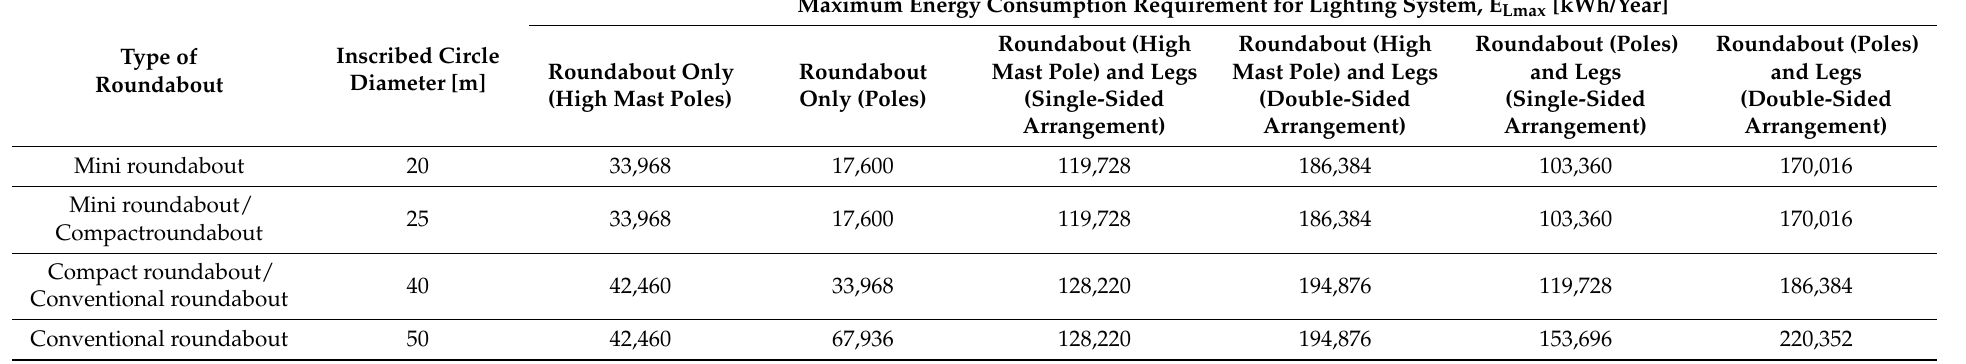
Table 7. Maximum energy consumption requirements for lighting systems in